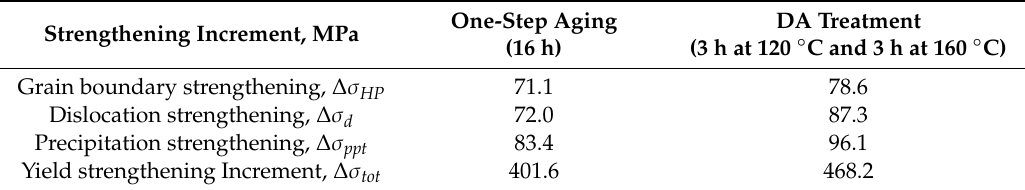
Table 3. Strengthening increment by di ff erent strengthening